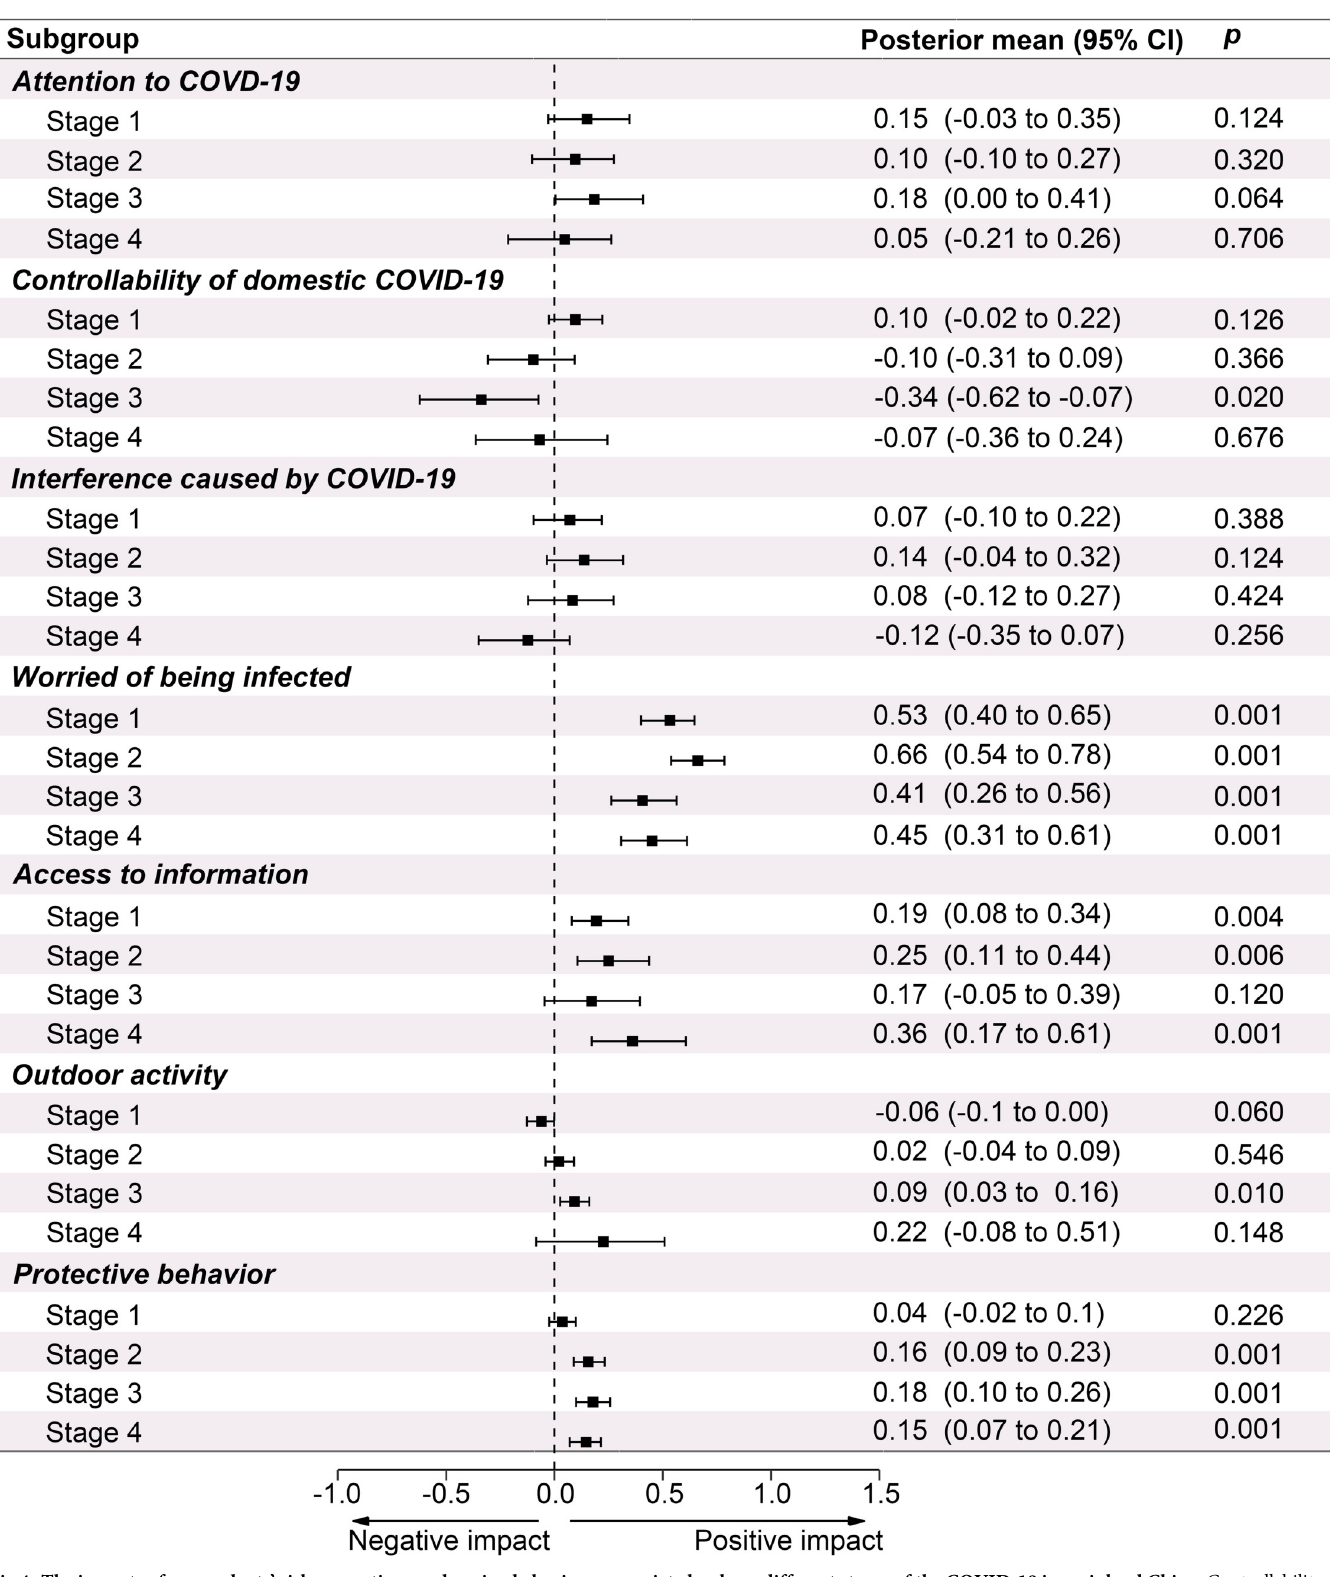
Fig 4. The impacts of respondents’ risk perceptions and coping behaviors on anxiety levels on different stages of the COVID-19 in mainland China. Controllability means belief in the controllability of domestic COVID-19 crisis. Access to information means the frequency of access to COVID-related news. https://doi.org/10.1371/journal.pone.0270229.g004 PLOS ONE | https://doi.org/10.1371/journal.pone.0270229 June 16,